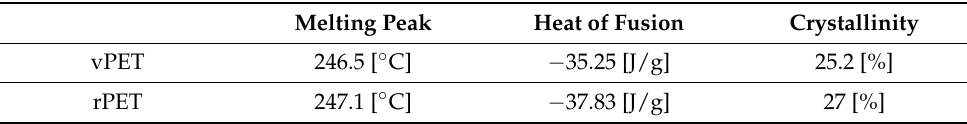
Figure 12. Second heating and cooling cycle of the DSC measurements at 10 K/min . Table 6. Results of the second heating cycle of the